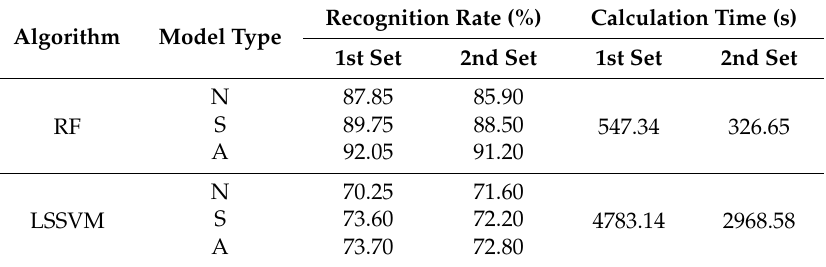
Table 4. Performance comparison results of 1st